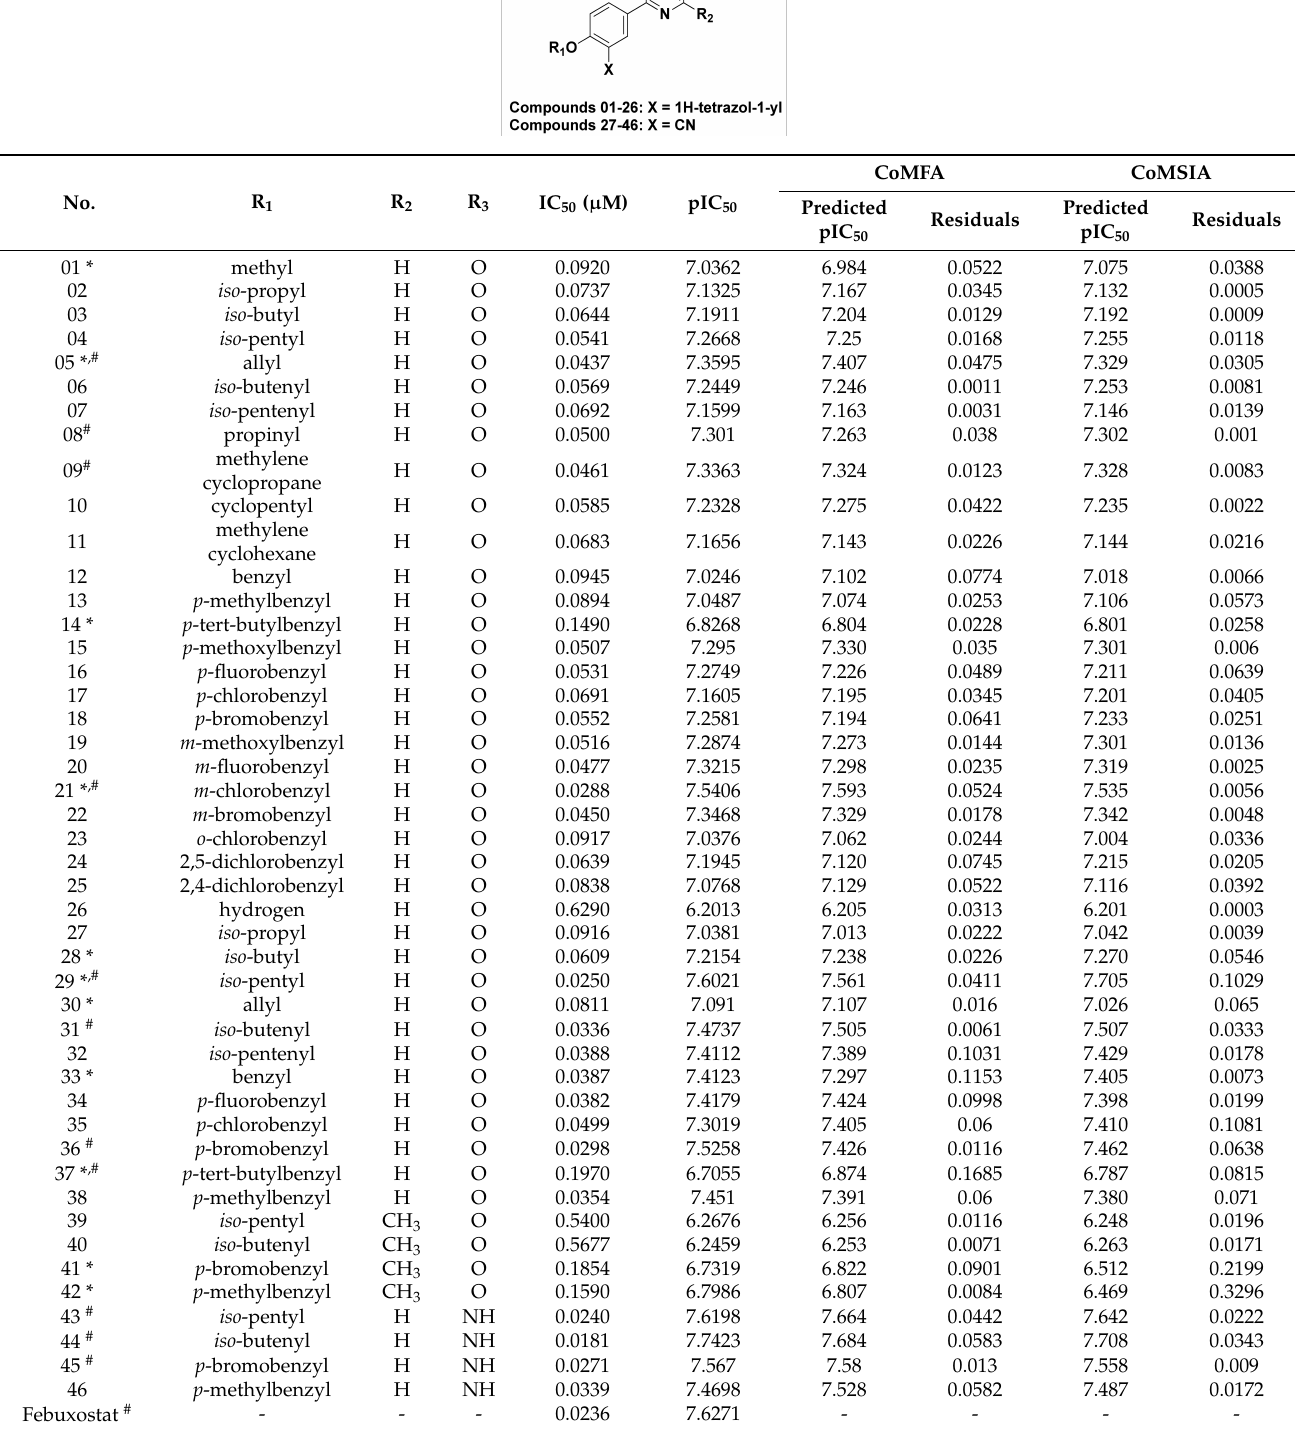
Table 1. Chemical structures of the used non-purine XOIs and their actual and predicted pIC 50